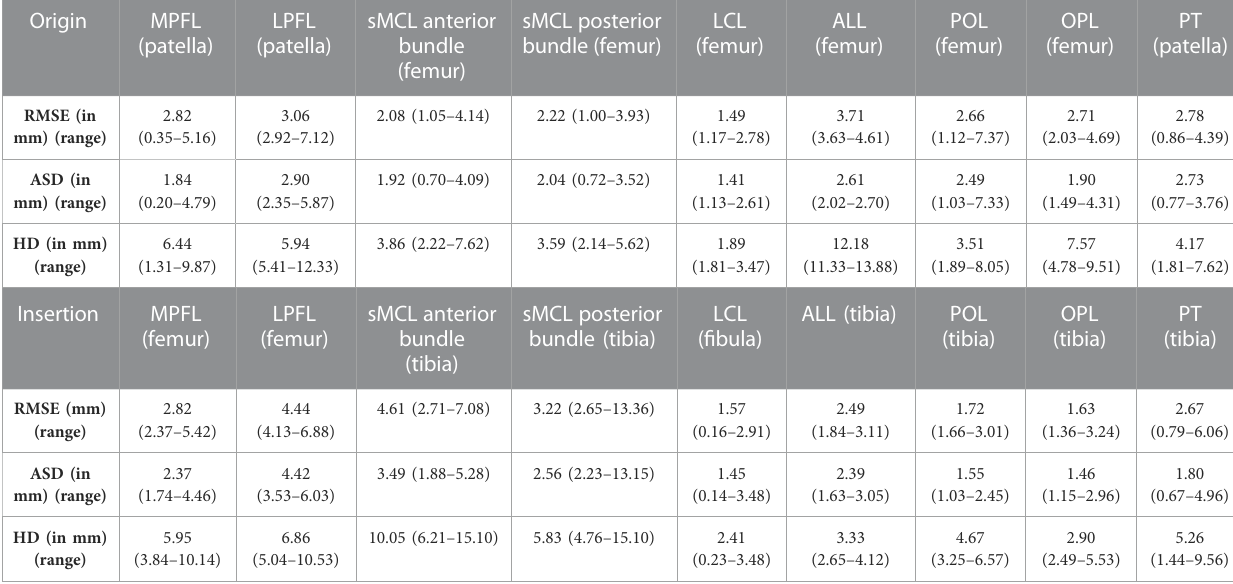
TABLE 3 Median RMSE, ASD and HD with range for the main knee joint ligaments and patellar tendon origin and insertion. Origin